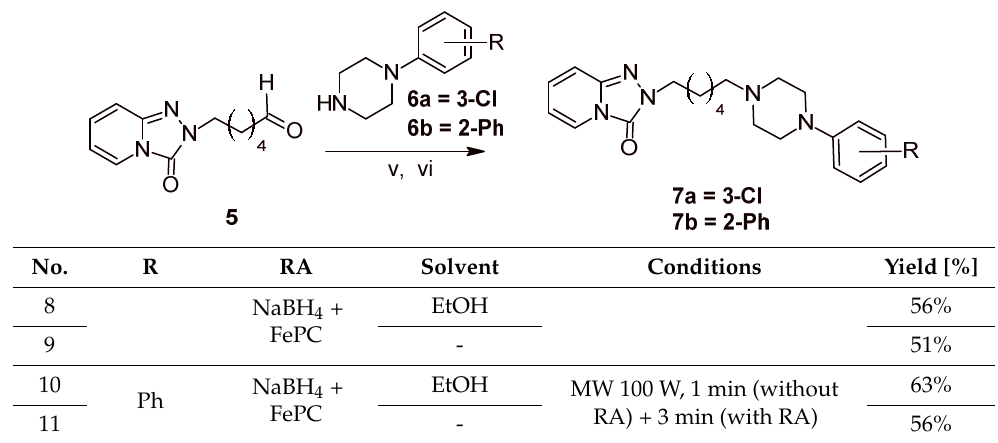
Table 1. Cont. Table 1. Development of steps v and vi of synthesis of 7a and 7b .